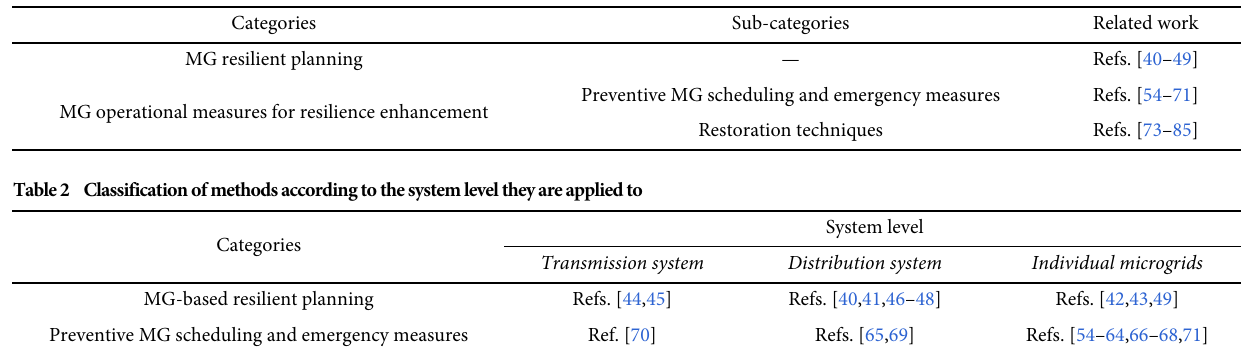
Table 1 Microgrids planning and operational mesures